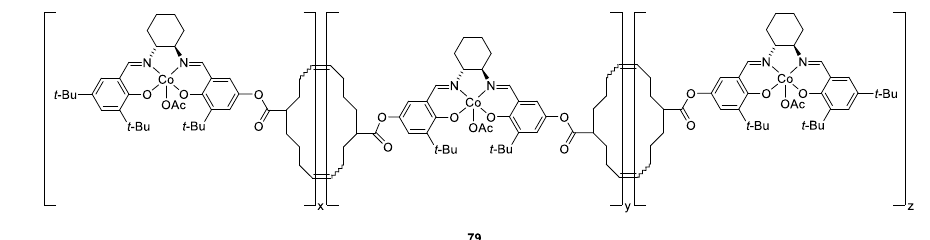
Figure 32. Cross-linked macrocyclic oligosalen catalyst 79 .